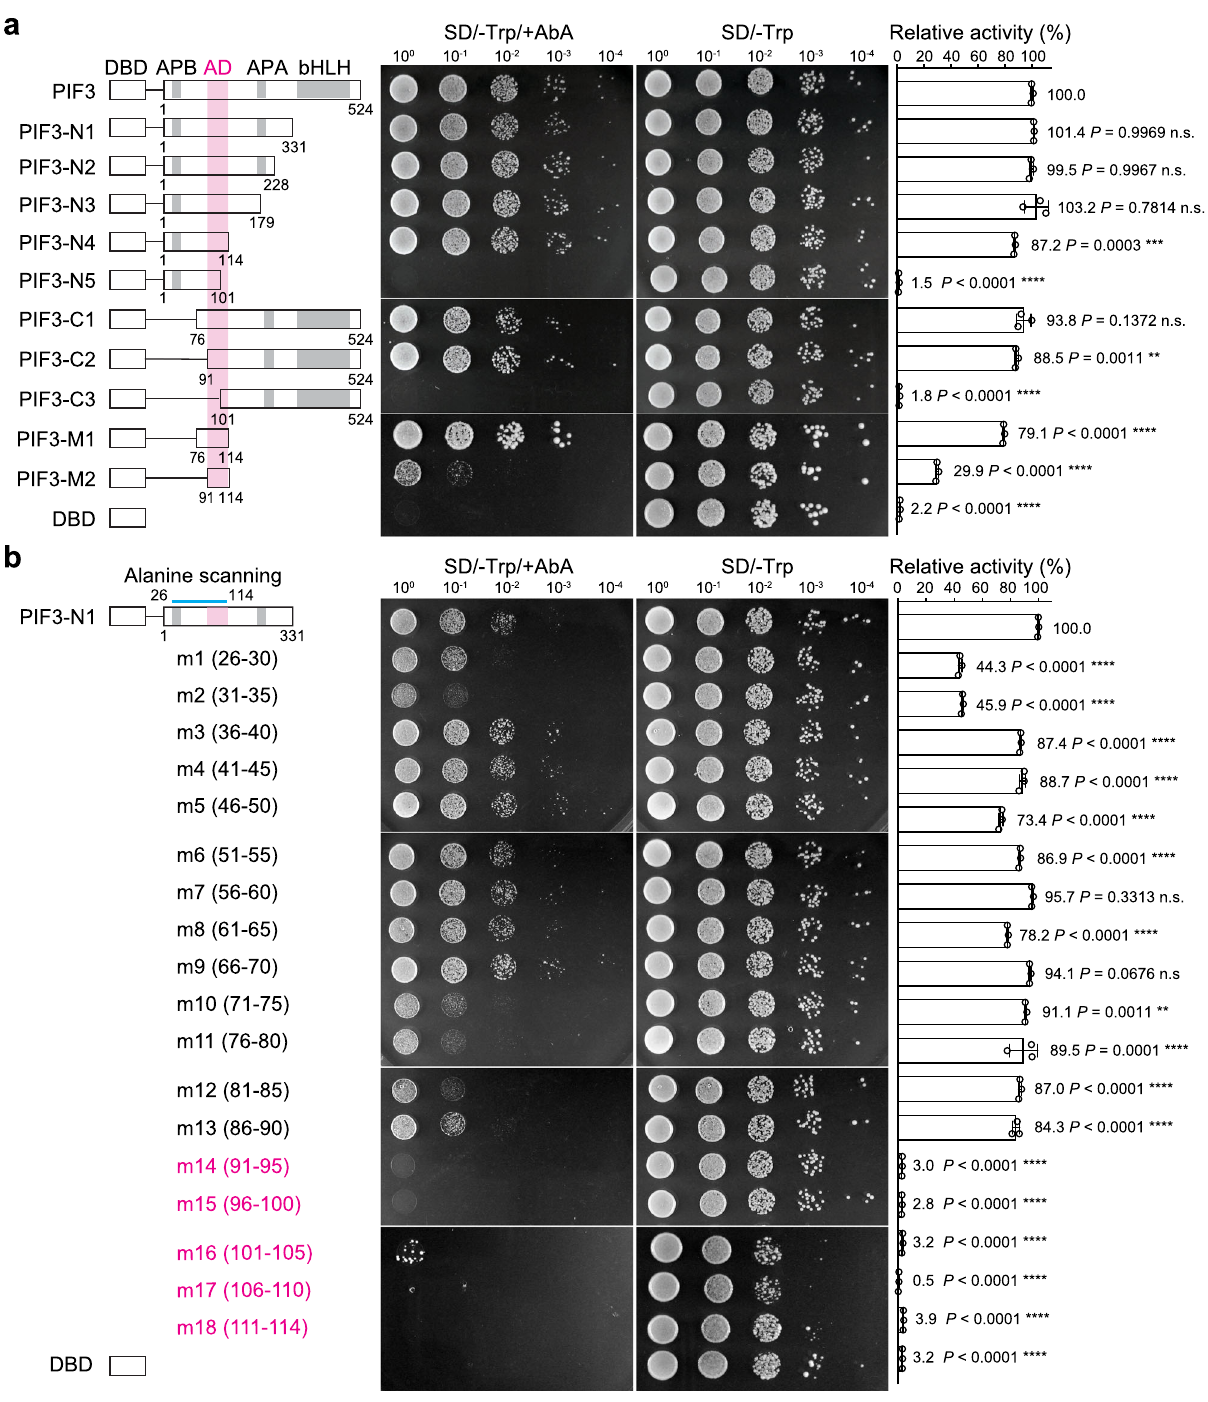
Fig. 1 The aa 91-114 region confers PIF3 ’ s AD activity in yeast. a Full-length and a series of truncation fragments of PIF3 were fused to the Gal4 DNA binding domain (DBD) as shown in the schematics, using the bait vector of the yeast two-hybrid system, and were evaluated for their transactivation activity in yeast. The magenta column highlights the aa 91-114 region. APB, active PHYB binding motif; APA, active PHYA binding motif. b Identi fi cation of the residues necessary for PIF3 ’ s AD activity via alanine scanning mutagenesis. A series of alanine-scanning mutants (m1 – m18) were generated between amino acids 26 and 114 (indicated by the blue line) in the PIF3-N1 construct. The range of the alanine-substituted amino acids for each mutant is shown in parentheses. The mutants that lost their transactivation activity are shown in magenta. a , b The middle panel shows serial dilutions of the yeast strains containing the respective constructs grown on either SD/-Trp/ + AbA or SD/-Trp (control) media. The right panel shows the relative transactivation activities quanti fi ed using the yeast liquid β -galactosidase assay. The transactivation activities were calculated relative to that of either PIF3 ( a ) or PIF3-N1 ( b ). DBD alone was used as a negative control. Error bars represent the s.d. of three biological replicates; the centers of the error bars represent the mean values. The numbers represent the mean value of the relative activity. The statistical signi fi cance of the changes between the sample and the control, PIF3 in a or PIF3-N1 in b , was analyzed by one-way ANOVA (Dunnett ’ s test, * P ≤ 0.05, ** P ≤ 0.01, *** P ≤ 0.001, **** P ≤ 0.0001, n.s. indicates no signi fi cant difference). The source data underlying the yeast liquid β -galactosidase assays in ( a ) and ( b ) are provided in the Source data fi